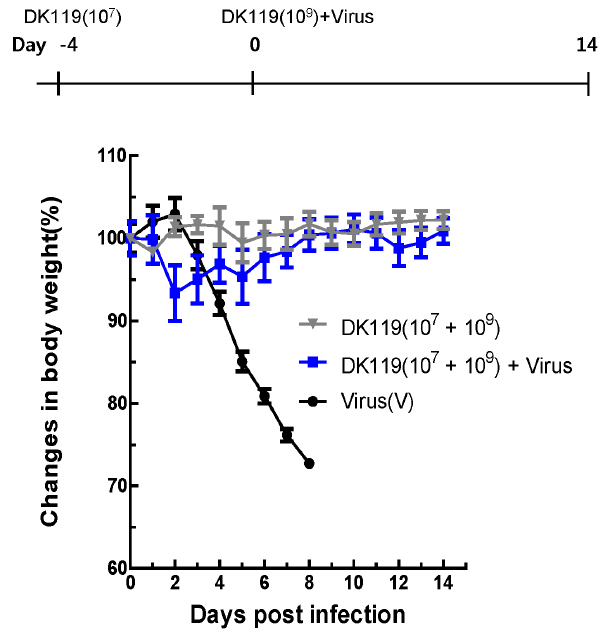
Figure 3. Pretreatment of a low dose of DK119(10 7 CFU) confers improved protection by preventing severe weight loss. A group of mice (n=6) was once treated intranasally with a low dose of DK119 (10 7 CFU per mouse). After 4 days of DK119 treatment, mice were infected with A/PR8 H1N1 virus (2.5 LD 50 ) in the presence of DK119 (10 9 CFU per mouse). The control group was infected with A/PR8 virus without DK119 and no pretreatment. Virus(V): mice infected with A/PR8 H1N1 virus, DK119(10 7 + 10 9 ) + V: mice pretreated with DK119 and infected with DK119 and A/PR8 H1N1 virus.DK119(10 7 + 10 9 ): mice treated with DK119 (10 7 CFU and 10 9 CFU per mouse). Bars indicate standard errors.